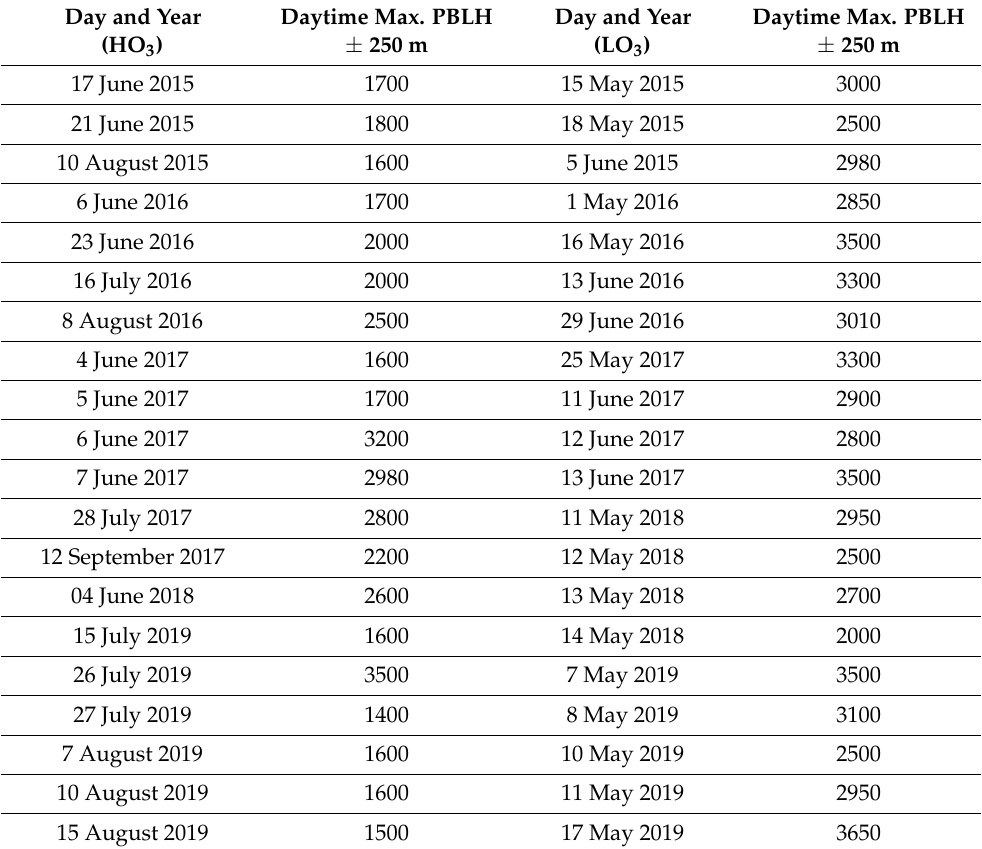
Table 1. High ozone (HO 3 ) and low ozone (LO 3 ) events from 2015–2019, for which daytime maximum PBLH was